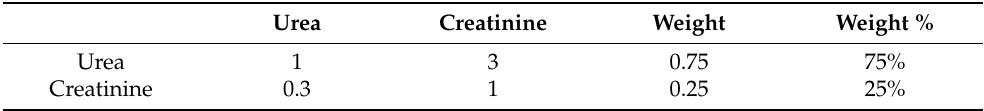
Table 6. Decision matrix and weights computation for Level 3 subcriteria derived from